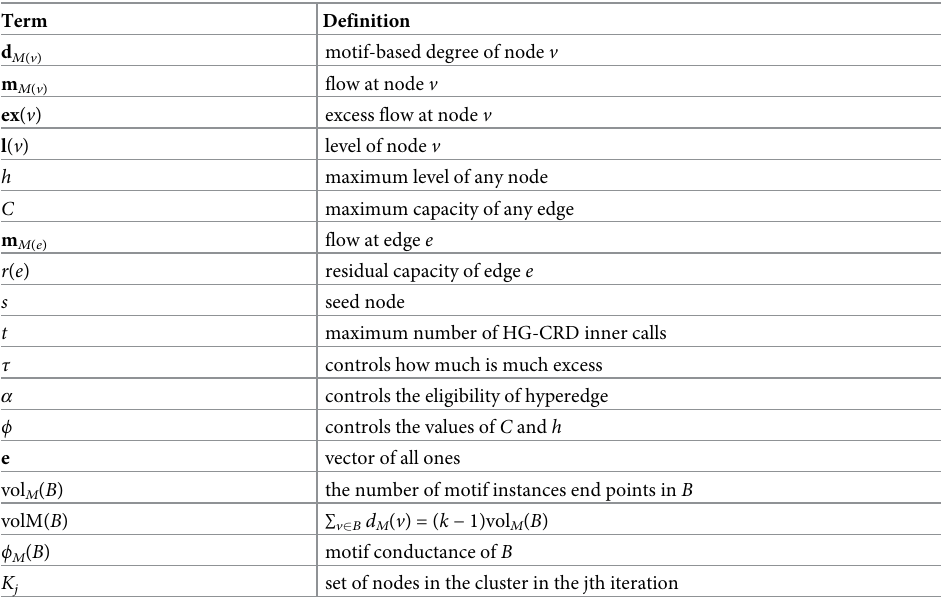
Table 1. Description of used